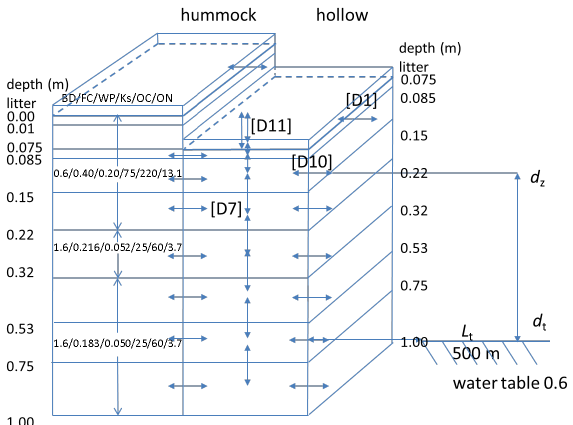
Fig. 1. Schematic representation of wetland landscape in ecosys . Depths are from the hummock surface to the bottom of each soil layer. Numbers in each soil layer are BD: Bulk density (Mgm − 3 ) , FC: field capacity (m 3 m − 3 ) , WP: wilting point (m 3 m − 3 ) , Ks: saturated hydraulic conductivity (mmh − 1 ) , OC: organic carbon (kgMg − 1 ) , ON: organic nitrogen (kgMg − 1 ) . Values for BD, OC and ON were measured at the field site. Values for FC, WP and Ks in the organic layers were derived from generalized relationships in Boelter 1969) and P¨aiv¨anen (1973), and those in the mineral layers from pedotransfer functions in Saxton et al. (1986). L t is distance to the external water table, d z and d t are depths of the internal (vari- able) and external (constant) water tables. Expressions in square brackets refer to equations in the Supplement by which indicated fluxes are